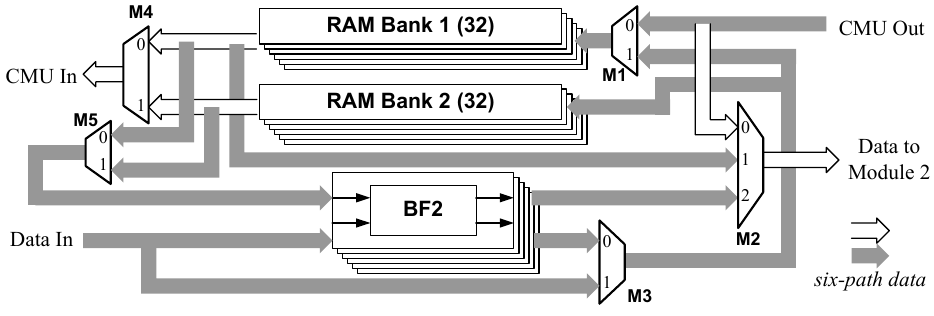
Figure 9. Block diagram of Module 1.